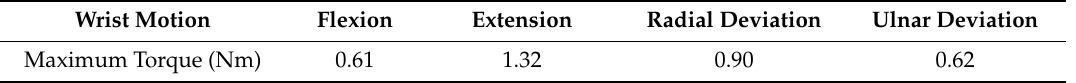
Table 2. Maximum torque of the robot in the direction of various wrist motions.